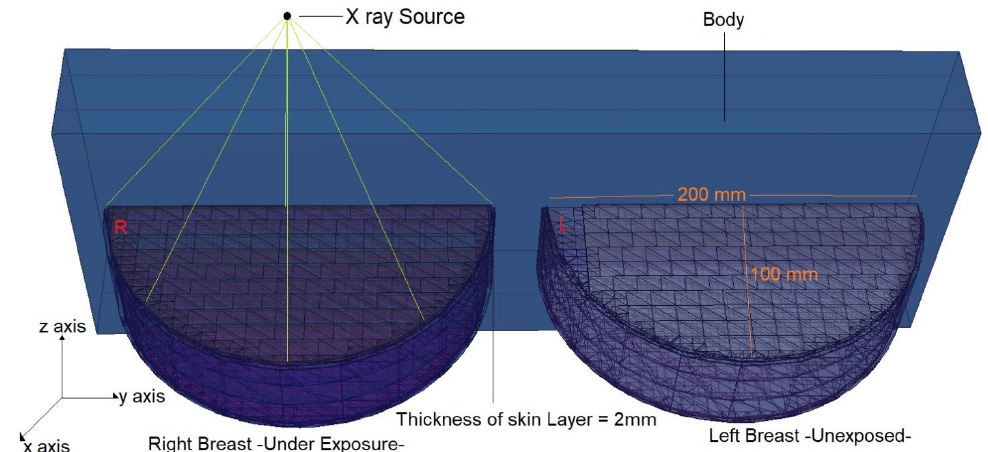
Figure 3. Three-dimensional view of modelled breast phantom, along with sizes and the location of X-ray source on the right breast.